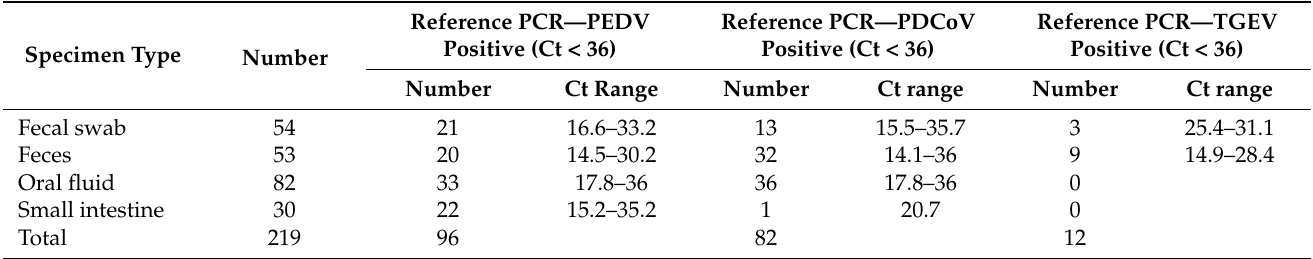
Table 8. Specimen types of 219 clinical samples and Ct ranges of positive samples tested by the reference PEDV/PDCoV/TGEV PCR.